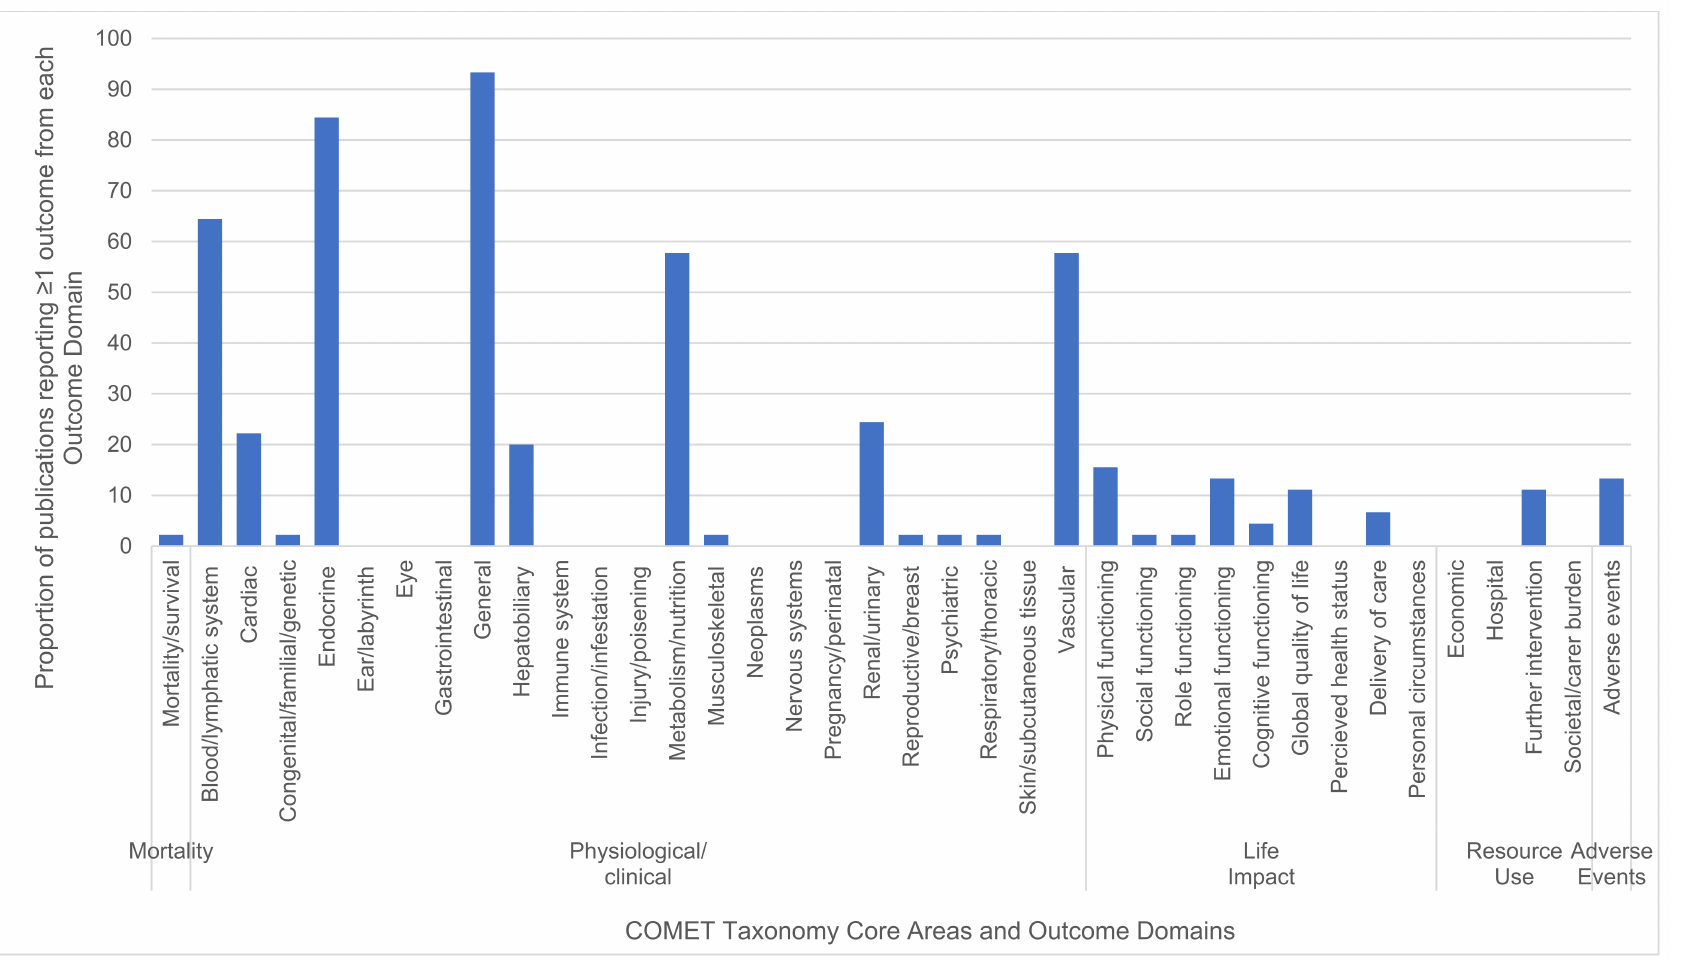
Figure 3. Proportion of studies reporting ≥ 1 outcome from each outcome